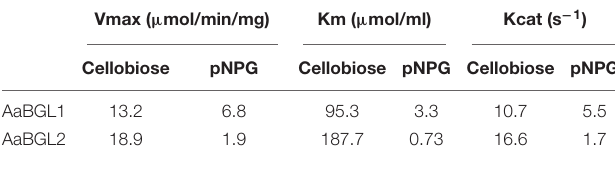
TABLE 3 | Kinetic parameters of AaBGL1 and